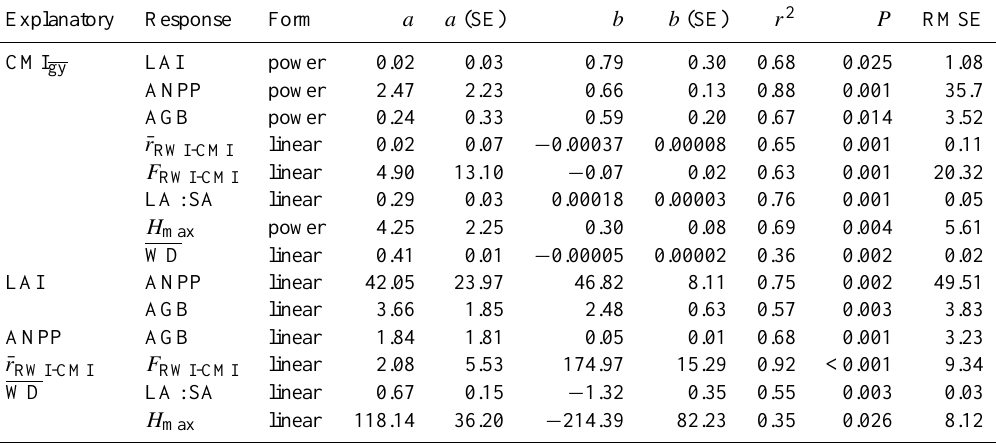
Table 3. Regression equations relating forest community carbon cycling, morphological characteristics, and long-term (1964–2013) mean growing-year climate moisture index (CMI gy ; mmyr − 1 ) across 12 sites in the eastern Cascade Mountains, Oregon. Forest characteristics include leaf area index (LAI; half of total surface area; m 2 leaf m − 2 ground), annual aboveground net primary productivity (ANPP;g Cm − 2 yr − 1 ) , aboveground live biomass (AGB; kg C m − 2 ) , leaf:sapwood area ratio (LA:SA; m 2 leaf cm − 2 sapwood), maximum tree height ( H max ;m), and average stem wood density (WD;gcm − 3 ) . Also included are the community-average correlation between tree-ring- width indices (RWI) and CMI from 1964 to 2013 ( ¯ r RWI-CMI ; unitless) and the fraction of individual trees in the community that exhibited a significant ( P < 0.05) positive RWI–CMI correlation ( ¯ r RWI-CMI ; %). Equations are either power form ( Y = aX b ) or linear ( Y = a + bX ), where a and b are fitted coefficients, with X and Y in units provided above.